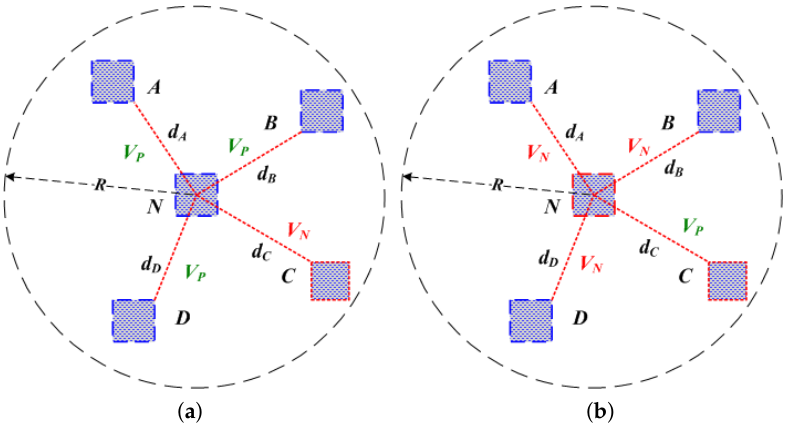
Figure 2. Reputation voting principle: ( a ) Case-1; ( b )